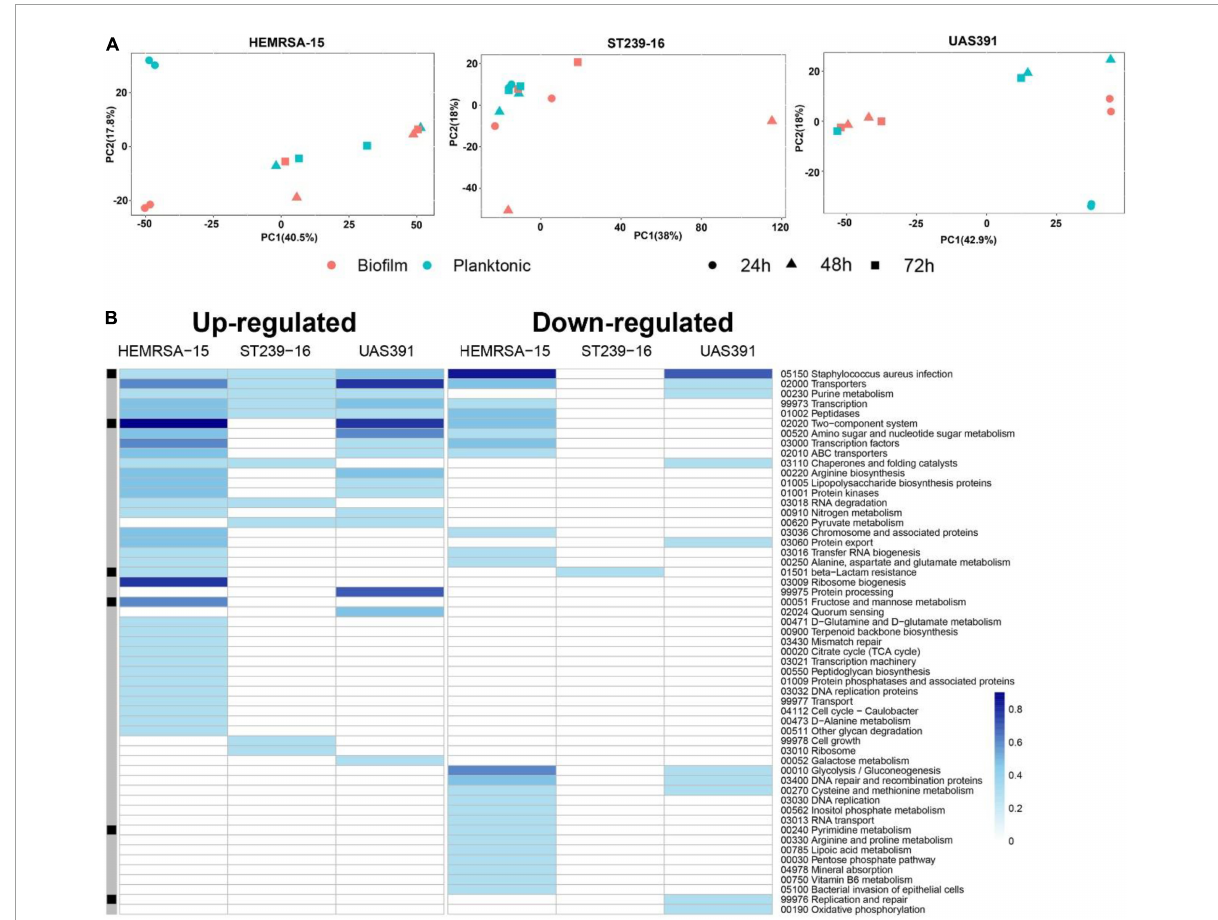
FIGURE1 Gene expression analysis of 24-h biofilm and planktonic phenotypes in three representative MRSA strains: HEMRSA-15 (left), ST239-16 (middle), and UAS391 (right). (A) Principal component analysis shows global differences between biofilm (red) and planktonic (blue) phenotypes of all three strains. (B) Metabolic pathway signatures of biofilm compared to planktonic bacteria after 24 h of growth. Identified DEGs were mapped against the KEGG database to obtain KO terms and associated metabolic pathways. Color-coded cells represent the number of enriched genes [log 10 (1 + number of enriched genes)] in the respective KEGG pathway in accordance with the color scale. Black–gray marking indicates whether some enriched genes in the KEGG pathway are linked to the accessory genome (consisting of genes that are not present in all the three genomes, black) or in the core genome (gray). Two biological repeats were used for each phenotype in each strain across time